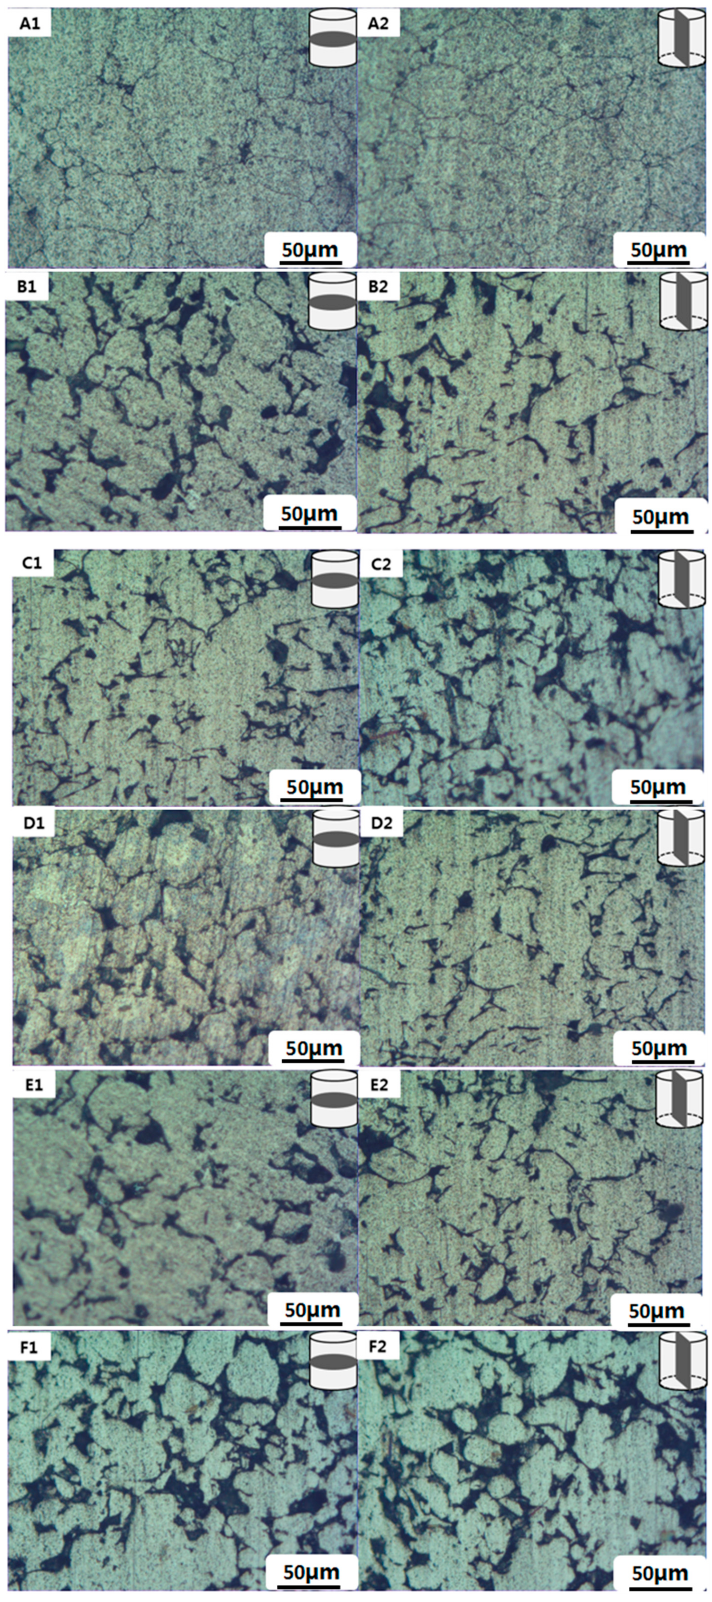
Figure 8. Microstructure for variation of MWCNTs volume fraction before open-die forging ( Al , A2 : Al6061; B1 , B2 : 1 vol %; C1 , C2 : 3 vol %; D1 , D2 : 5 vol %; E1 , E2 : 7 vol %; F1 , F2 : 10 vol %).